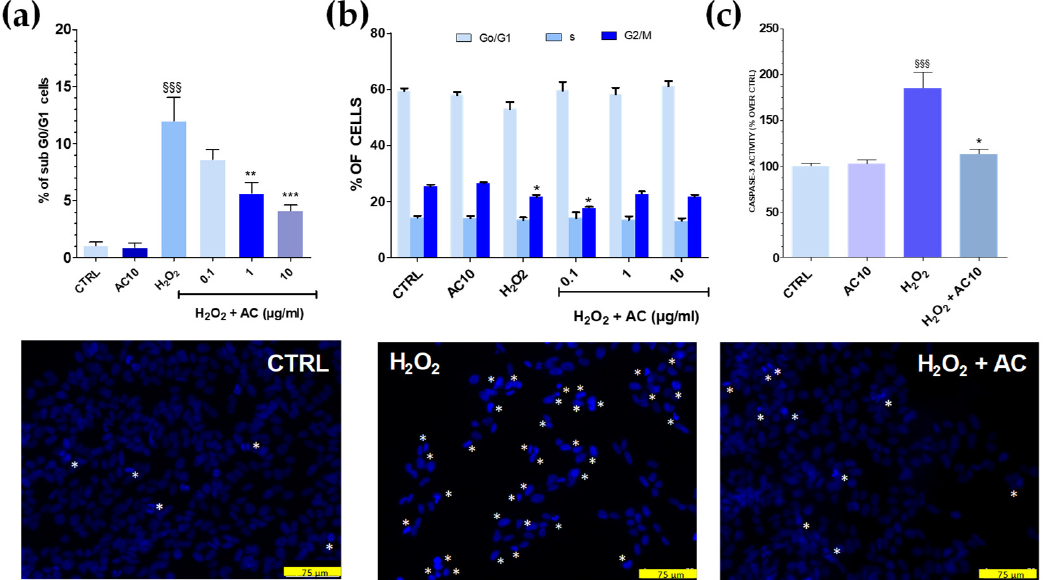
Figure 4. Effects of AC on OS-induced changes in SH-SY5Y cell cycle, DNA condensation, and caspase-3 activity. Cells were treated with AC (1–10 µ g/mL) for 1 h before OS and for the following 24 h. OS was reproduced by using H 2 O 2 (25 µ M for 1 h + 24 h with medium). The effects of AC per se were tested at 10 µ g/mL (AC10). ( a ): Cell cycle analysis: percent of cells in the sub G0/G1 (apoptotic) phase; ( b ) percent of cells in the G0/G1, S, or G2/M phase determined by flow cytometry after propidium iodide staining; ( c ) caspase-3 activity, assessed by using a caspase-3 specific substrate which releases the fluorescence probe AMC when activated. AC, in this case, was used at 10 µ g/mL. Data are reported as means ± SEMs. §§§ p < 0.001, vs. untreated cells; * p < 0.05, ** p < 0.01, *** p < 0.001 vs. H 2 O 2 (ANOVA and Bonferroni post-hoc test). (Lower panels): Apoptotic cells detected by DAPI staining. Asterisk indicates cells with fragmented nuclei and condensed DNA, considered apoptotic. Each photograph was representative of three independent observations (scale bar 75 µ